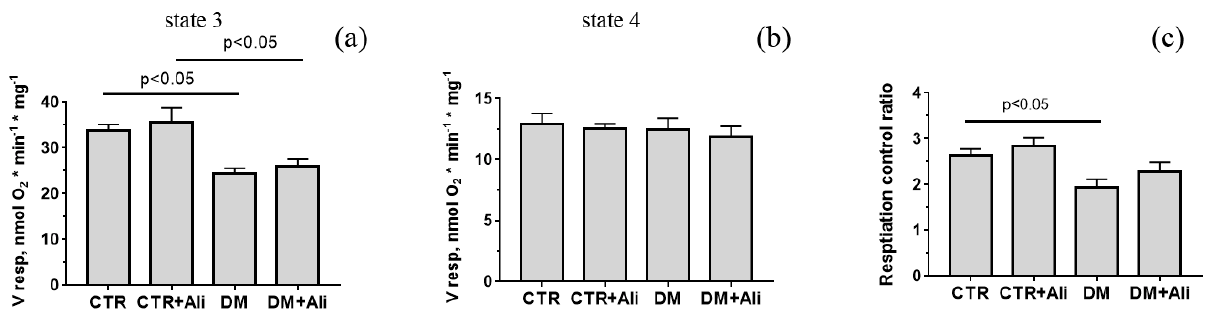
Figure 2. Parameters of respiration and oxidative phosphorylation of mouse heart mitochondria of the experimental groups. ( a ) The rate of respiration of mitochondria in state 3. ( b ) The rate of respiration of mitochondria in state 4. ( c ) Respiration control ratio. Medium composition: 130 mM KCl, 5 mM NaH 2 PO 4 , 10 µ M EGTA, and 10 mM HEPES–KOH, pH 7.4. Respiration of mitochondria was fueled by 2.5 mM glutamate and 2.5 mM malate. Mitochondrial respiration in state 3 was initiated by 200 μ M ADP. The results are presented as means ± SEM ( n = 4).